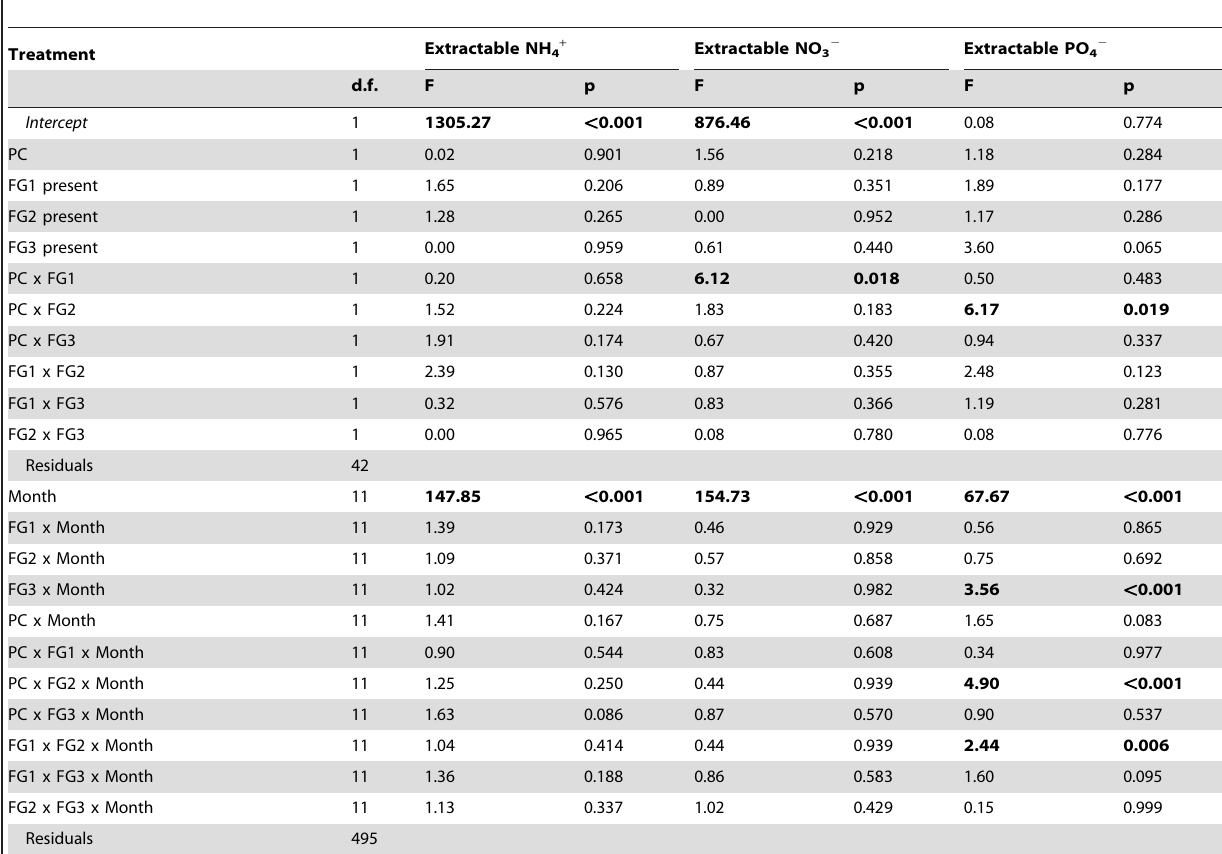
Table 6. Results of linear mixed effects models testing precipitation change (PC) and functional group (FG) treatment effects uponseasonal soil extractable nutrient